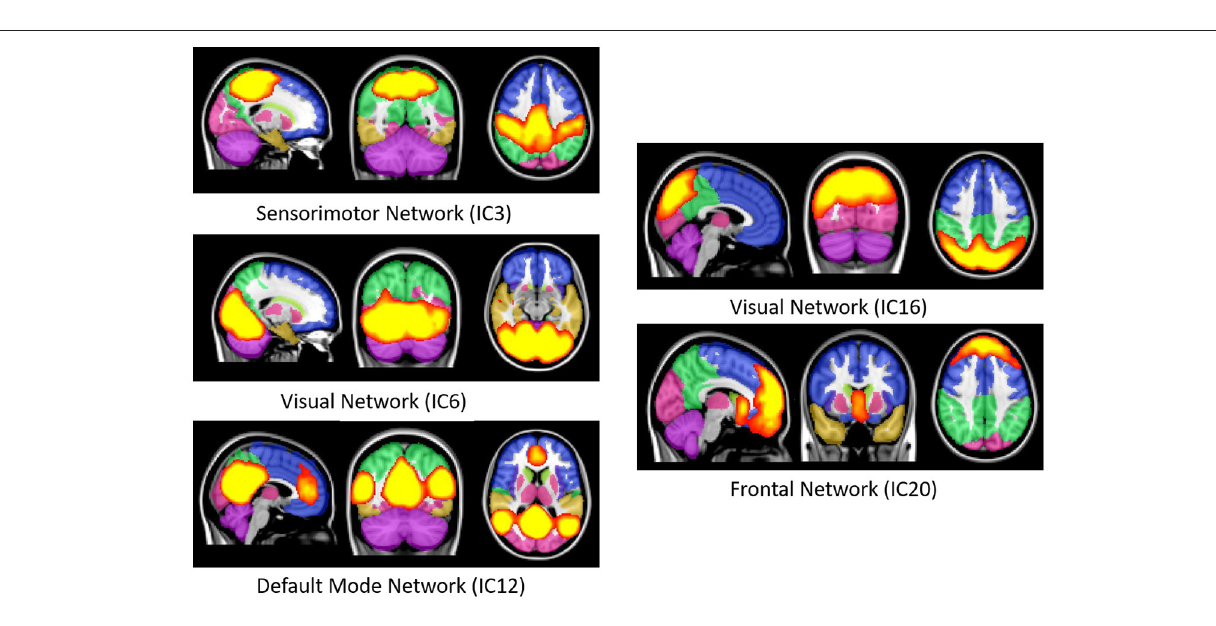
FIGURE 2 | Well-known resting state functional networks acquired from the selected independent component of group ICA result. First image in each network figure depicts the sagittal, second depicts the coronal and third depicts the axial view. The bright yellow color represents the IC’s while the pale background colors depicts the MNI152 atlas ROI’s. IC, Independent component; ICA, Independent component analysis; MNI, Montreal neuroimaging